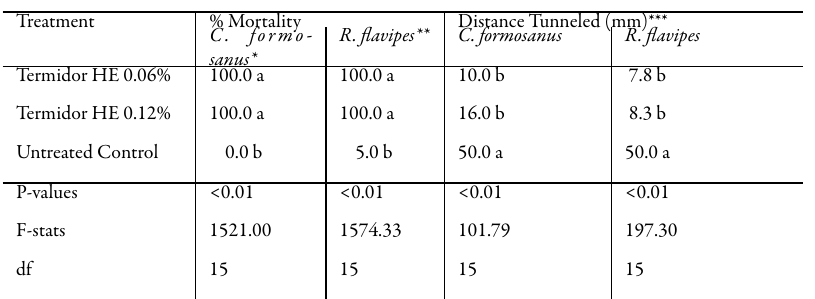
*All treatments caused 100% mortality in the C. formosanus by 120 h post-treatment. **All treatments caused 100% mortality in the R. flavipes by 96 h post-treatment. ***Maximum distance tunneled could not exceed 50 mm. Means followed by the same letter in the same column were not significantly different (P=0.05) as per Tukey’s Honest Significant Difference